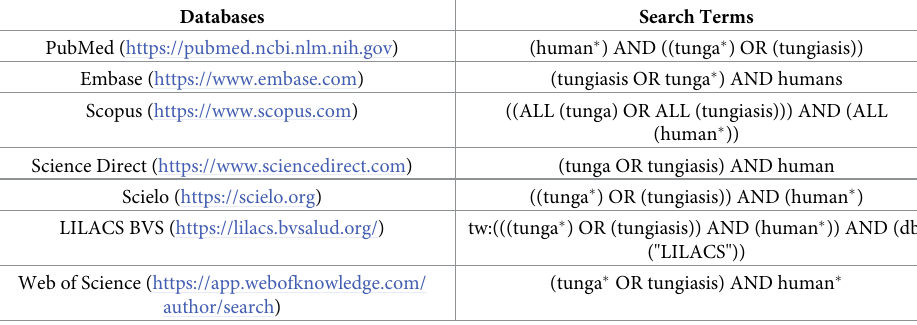
Table 1. Databases, websites and search terms used in the review.